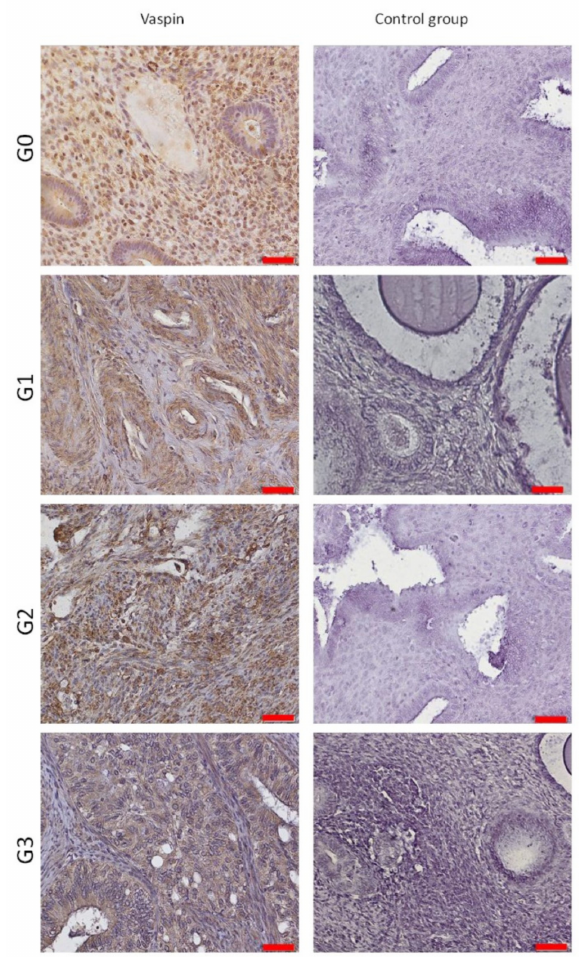
Figure 5. Tissue expression of vaspin in grading